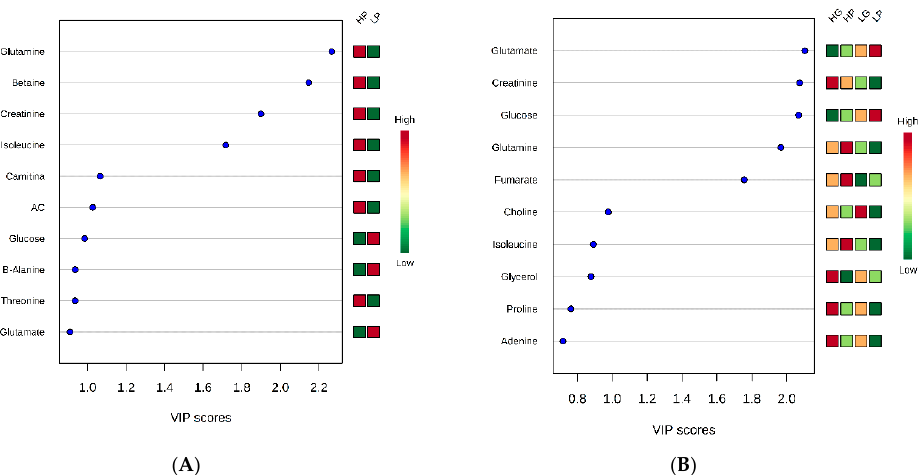
Figure 2. Variable importance in projection (VIP) plot value analyses obtained from ( A ) high precocity (HP) and low precocity (LP) animals; and ( B ) high growth (HG), high precocity (HP), low growth (LG), and low precocity (LP) animals. AC: Acetylcarnitine.